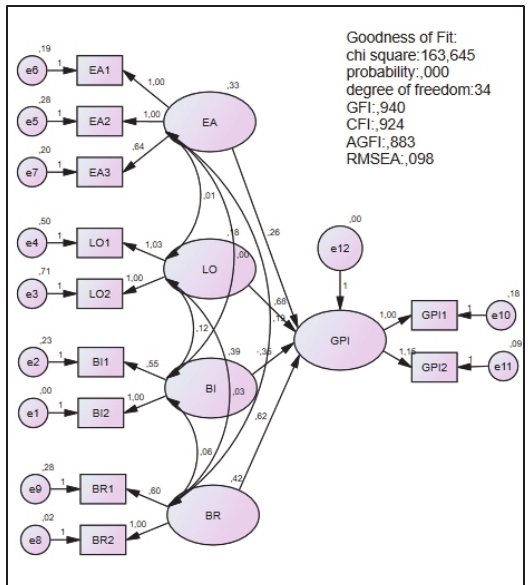
Fig. 1. Model Recommendation